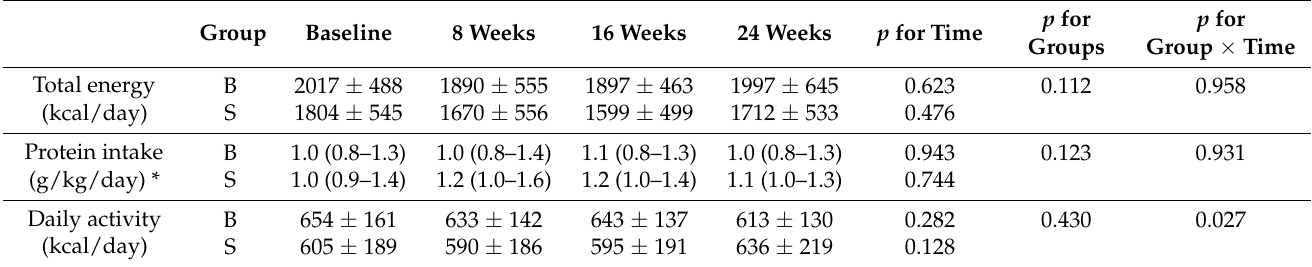
Table 2. Dietary intake and activity during the 24-week intervention